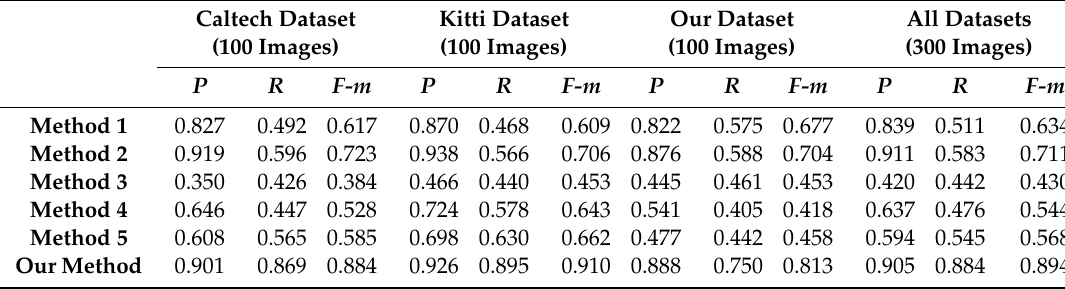
Table 2. Precision ( P ), recall ( R ), and F-measure ( F-m ) indicators of the four